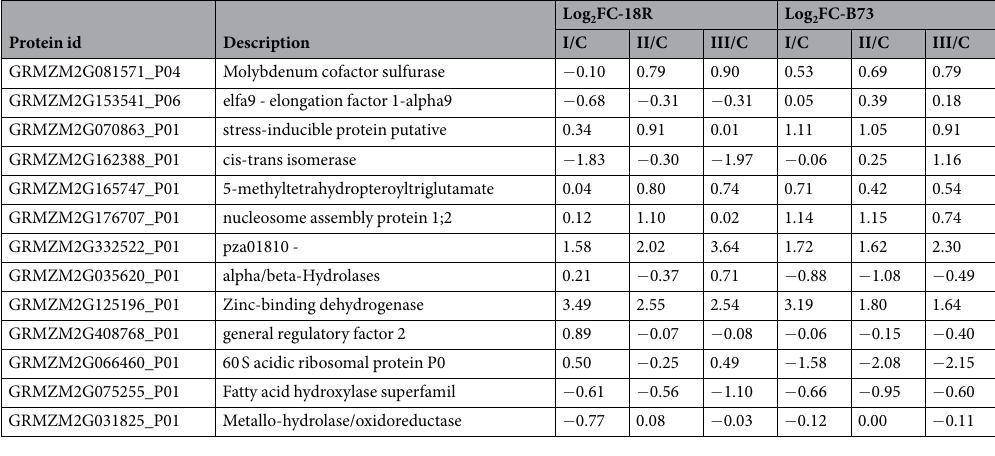
Table 1. Metal ion response or binding DEPs.